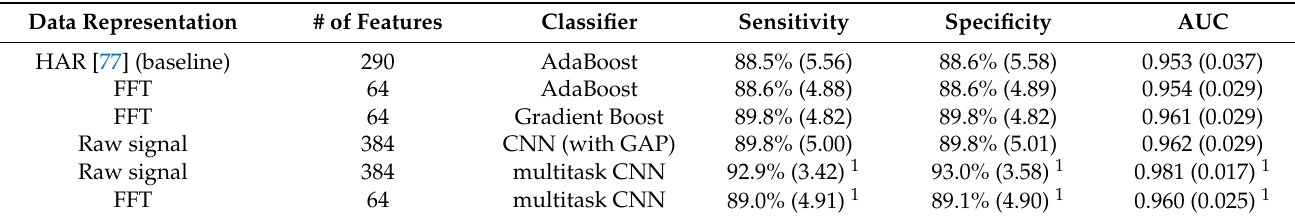
Table 4. Results for the leave-one-subject-out (LOSO) evaluation of the context classifier using different approaches. Data Representation